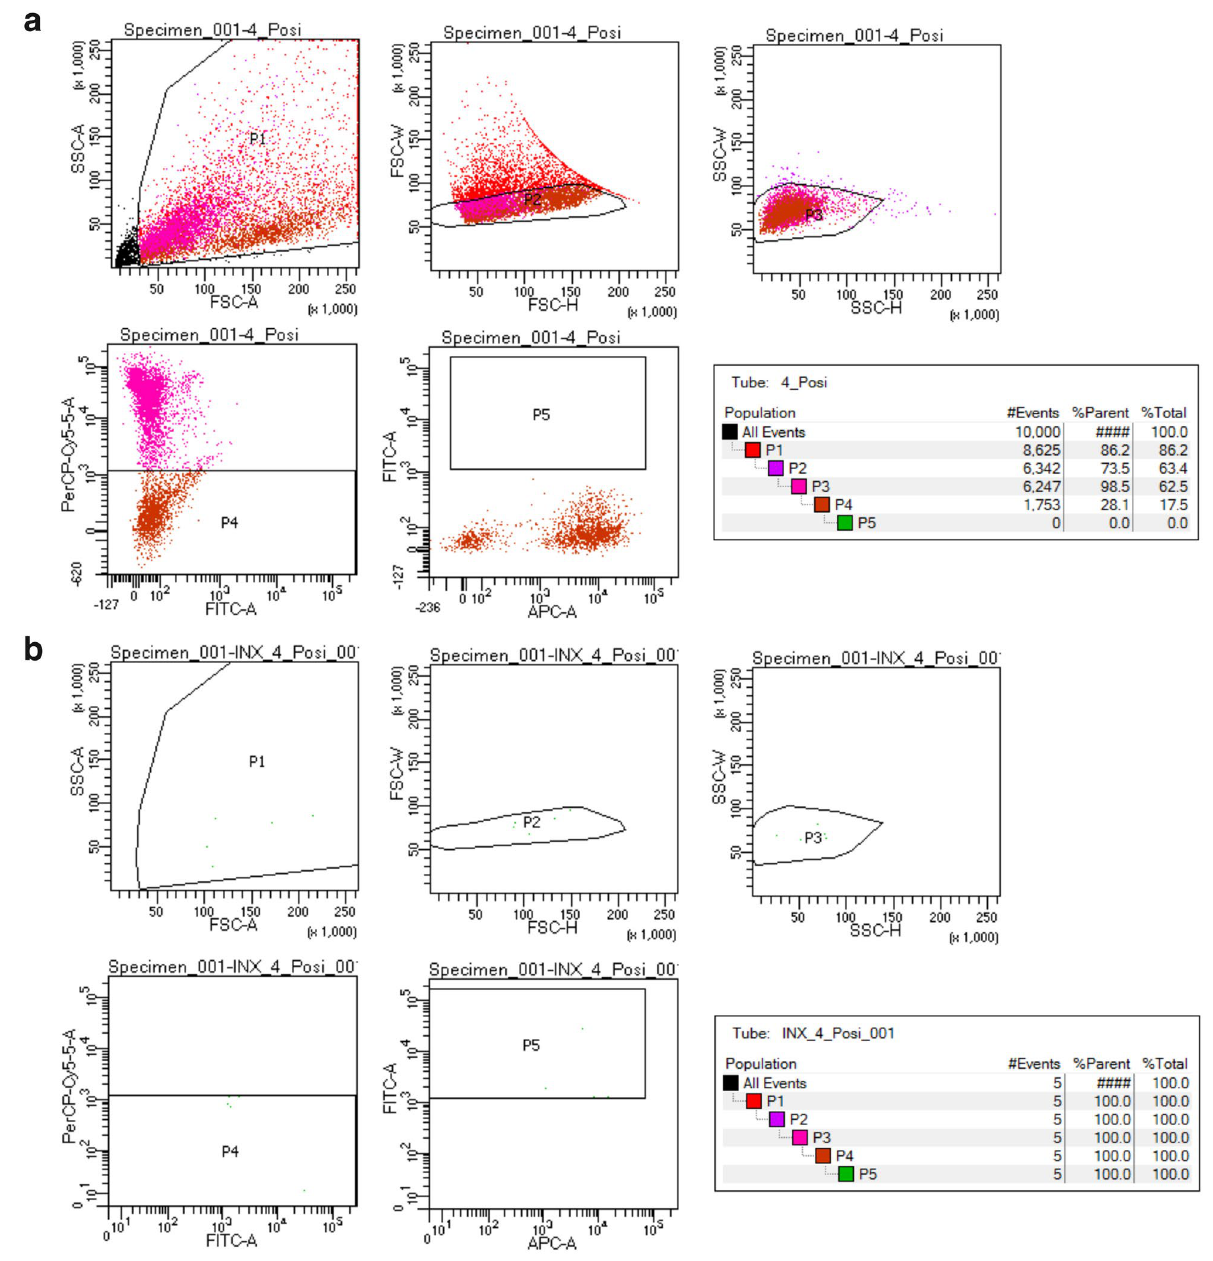
Figure 2. Gating conditions for sorting MMc cells. Noise and/or debris were removed with gate P1, and then doublet cells were removed with gate P2 and P3. Live-GFP positive cells (PerCP-Cy5-5 negative and FITC positive) were isolated by gate P4 and P5. ( a ), overall sorting result of a fetal cell sample. P5 gate was set for isolating MMc cells. Since all sorted cells cannot be plotted because of the counting limitation of processed cells even if the sample contains MMc cells, it will disappear from the display. ( b ) Therefore, we conducted index sorting at the same time. Panel ( b ) shows that 5 target cells were actually present and sorted. The images were created by default programs available in BD AriaIIIu (https:// www. bdbio scien ces. com/) and Adobe Photoshop (https:// www. adobe. com, Photoshop